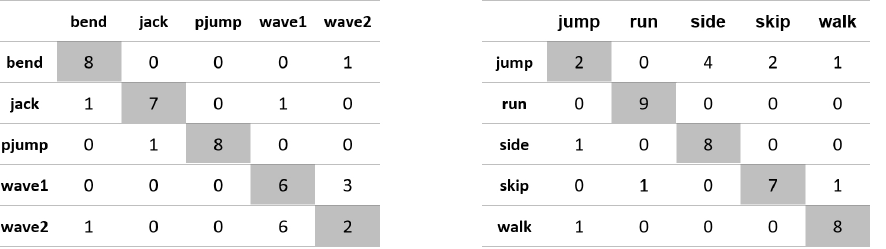
Figure A27. Confusion matrices for the experiment using the ‘upper-occlusion’ database, MBR perimeter and Euclidean distance.